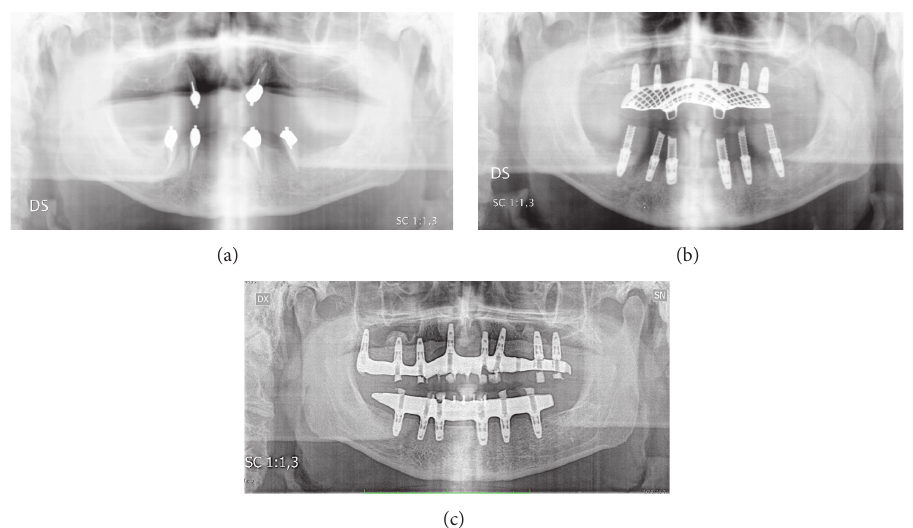
Figure 1: Orthopantomography of the patient at first visit (a), 18 weeks (b), and 96 weeks